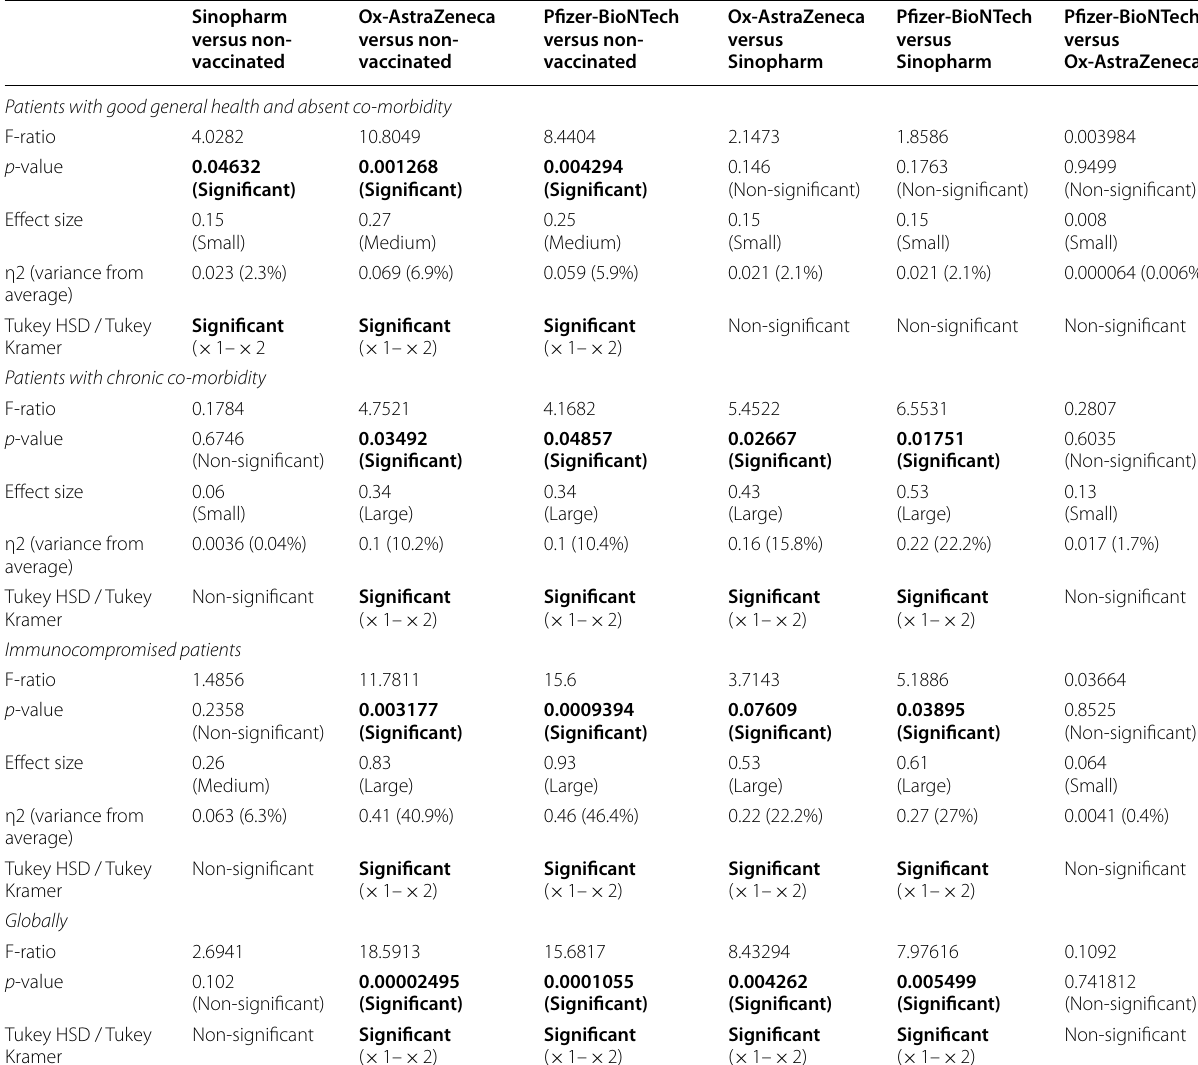
Table 3 Comparative analysis of variance (ANOVA) results